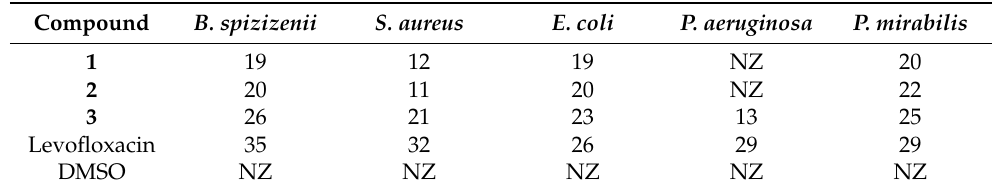
Table 1. The zones of inhibition (mm) for 2.0 mM of the synthesized compounds and levofloxacin against five different bacterial strains.